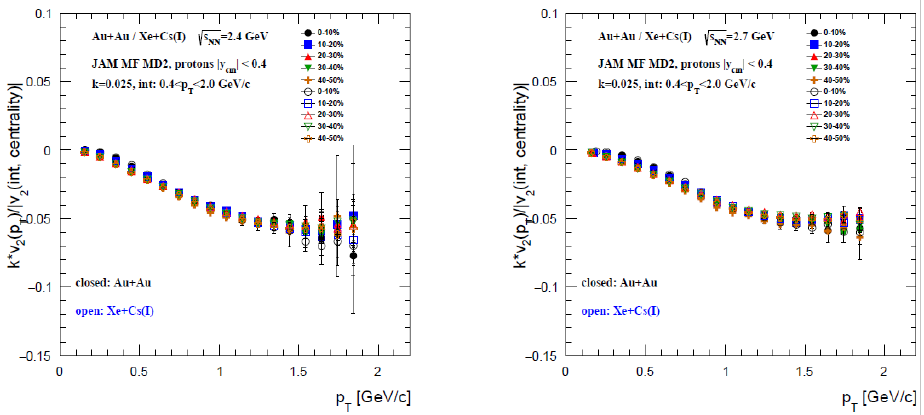
Figure 28. v 2 (centrality, p T ) divided by k = 0.25 times the p T integrated value | v 2 (int,centrality)| for protons from Au + Au and Xe + Cs collisions at ( right panel ). The results for JAM model with hard momentum dependent mean-field MD2 ( K 0 = 380 MeV)